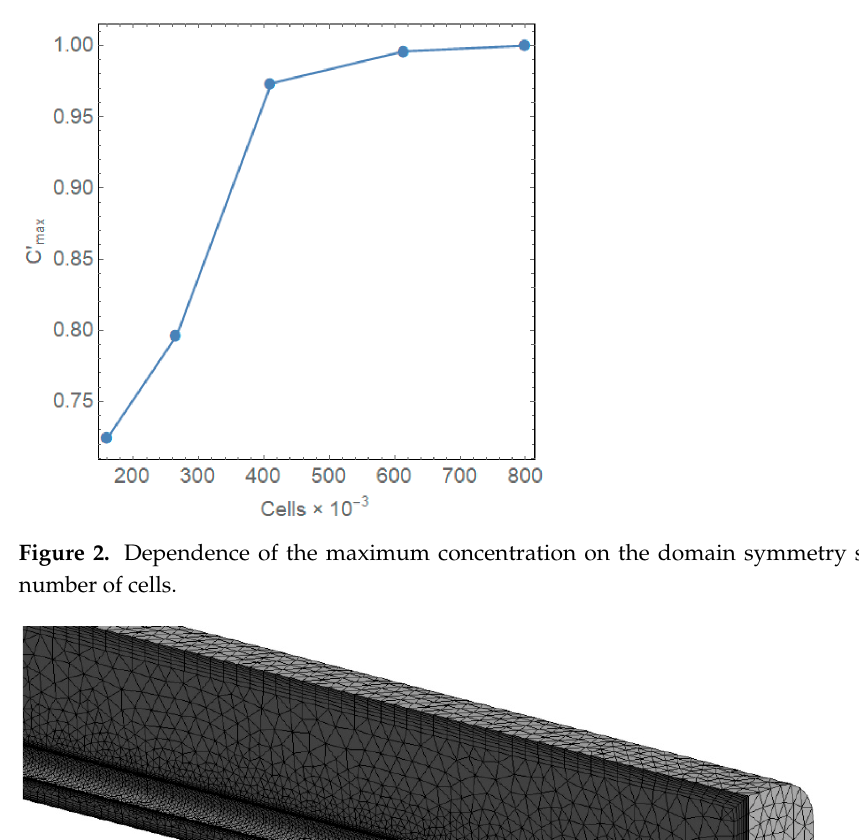
Figure 3. Part of the domain with the computational mesh.